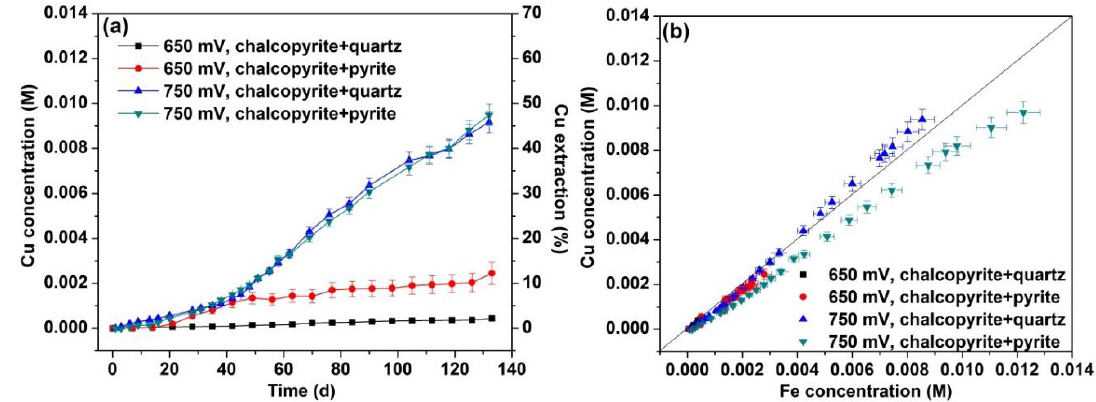
Figure 1. Leach data resulting from the flow-through experiments conducted at 75 °C, pH 1.0, 650 mV and 750 mV: ( a ) Cu concentration and % extraction versus time; ( b ) Cu concentration against Fe